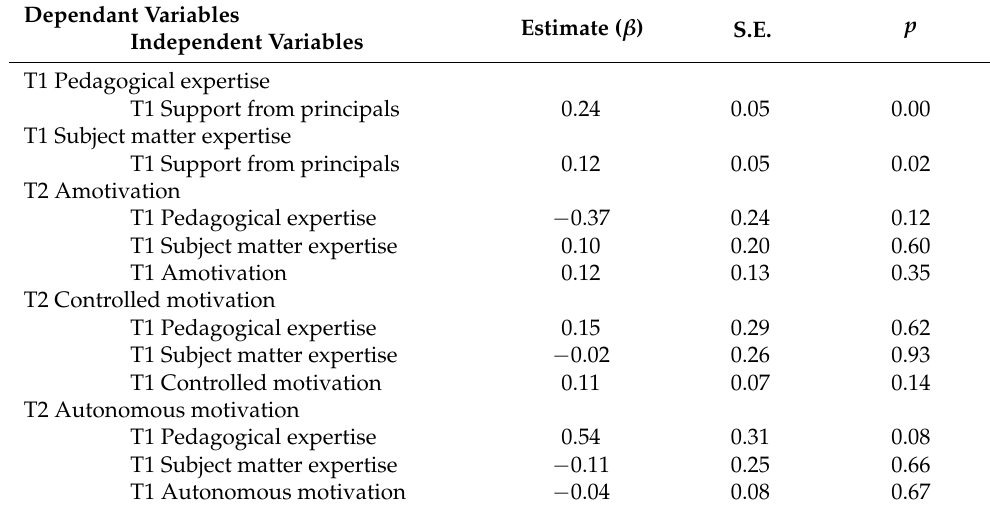
Table 3. Standardized Estimates for the Structural Model: Support from Principals. TPI. and Self- determined Motivation.